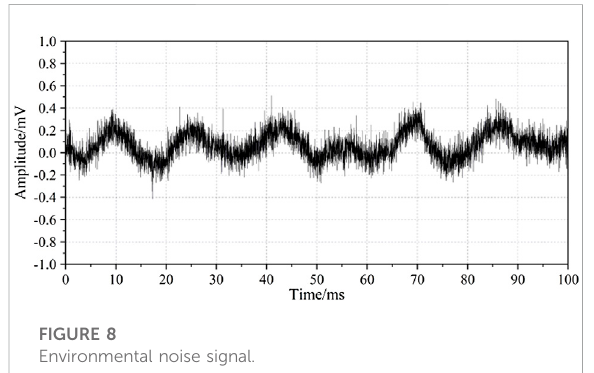
FIGURE 8 Environmental noise signal.